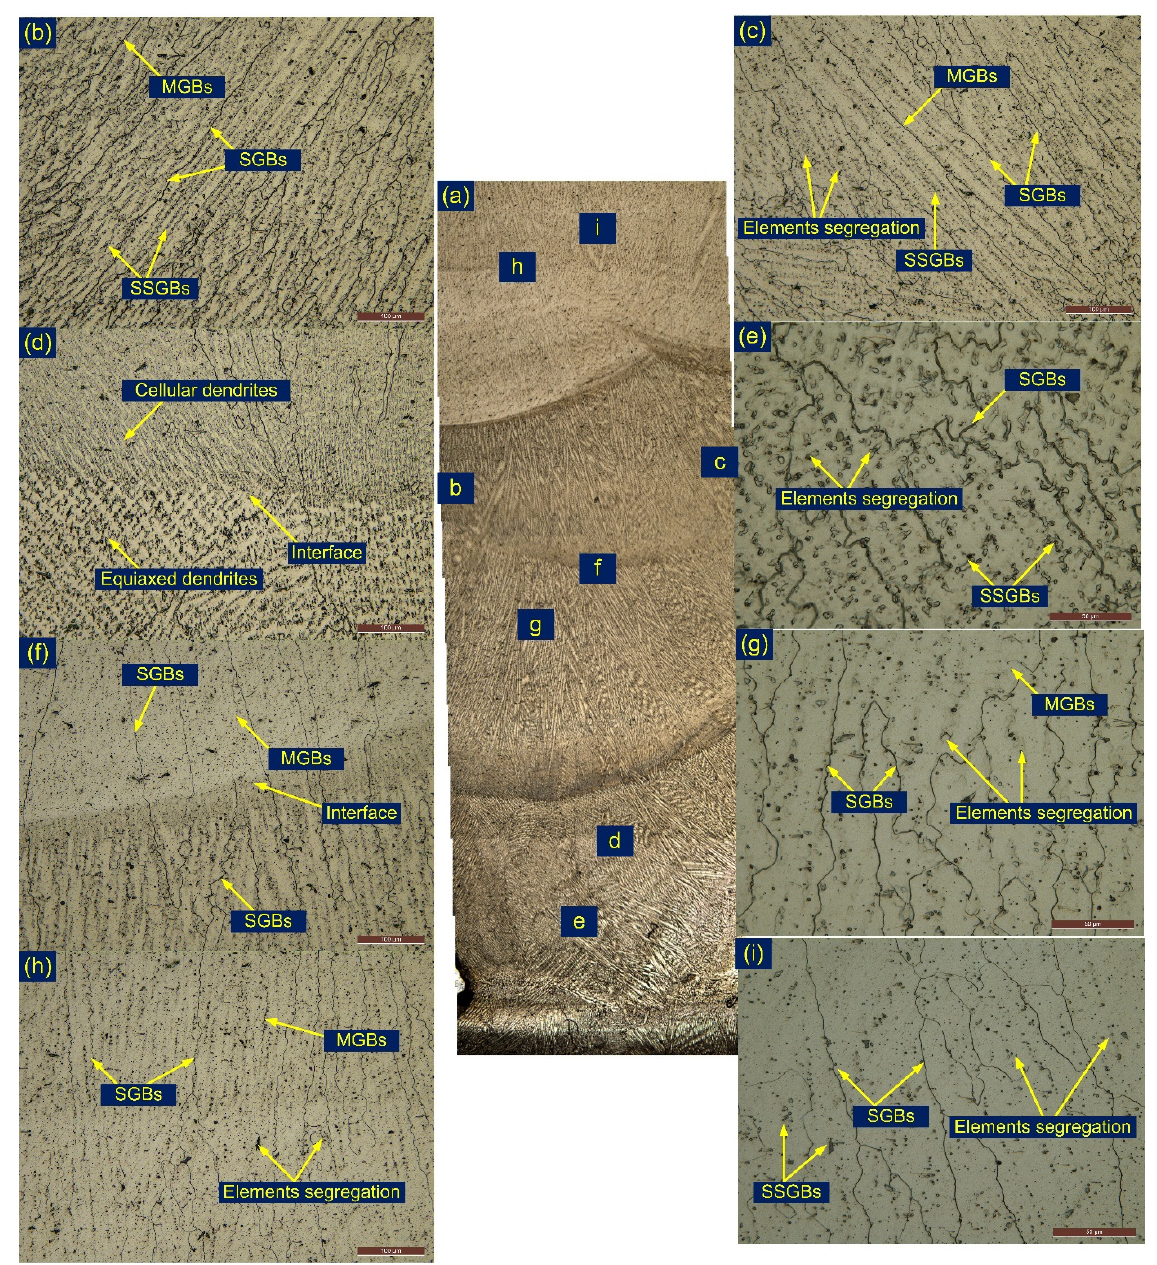
Figure 8. ( a ) Cross-sectional view of the weld metal, ( b , c ) weld metal near the fusion line, ( d , e ) root area of the weld metal, ( f , g ) center region of the weld metal corresponding to filling pass, ( h , i ) top region of the weld metal. Table 2. Tensile test results of test coupons tested at room temperature and high